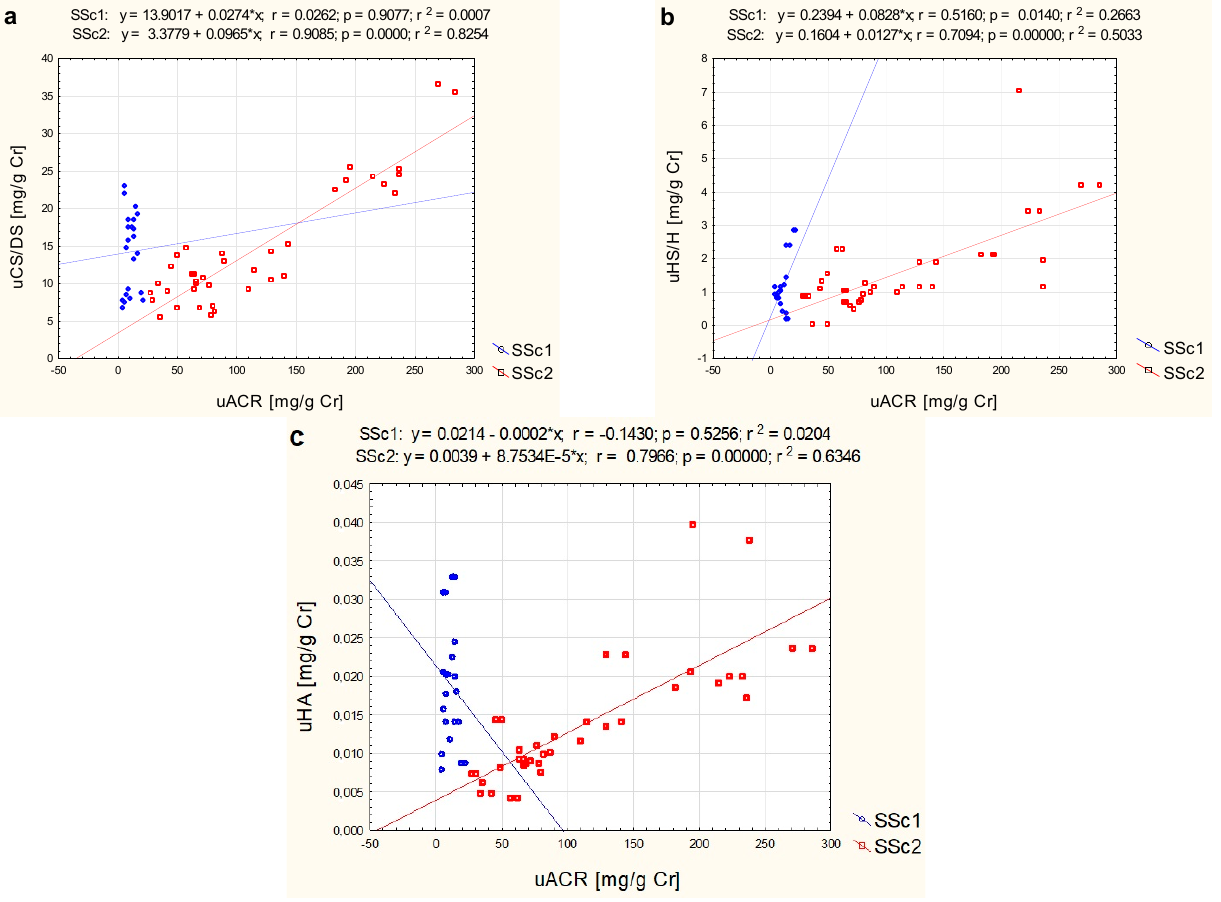
Figure 2. Correlation analysis between urinary (u) CS/DS ( a ), HS/H ( b ), HA ( c ), and uACR in patients with systemic sclerosis and normoalbuminuria (SSc1) or microalbuminuria (SSc2), presented as a scatter plot with fitted regression line.